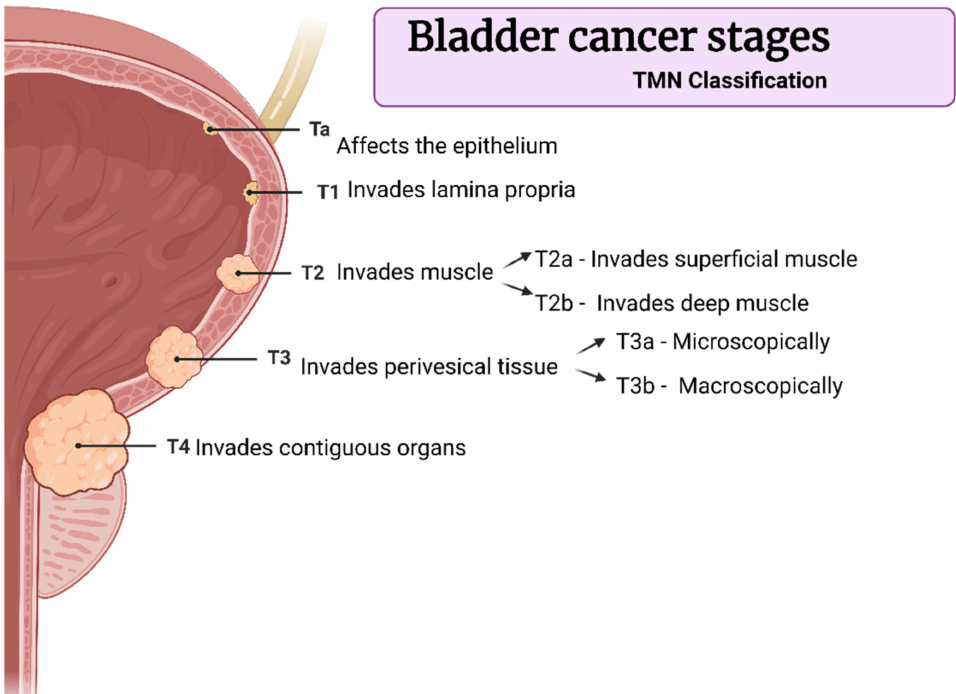
Figure 2. Bladder cancer stages according to TNM classification. Created with BioRender.com adapted from Surgery, 34:10, Down et al., Bladder Cancer, Pages 532–539, Copyright (2016), with permission from Elsevier